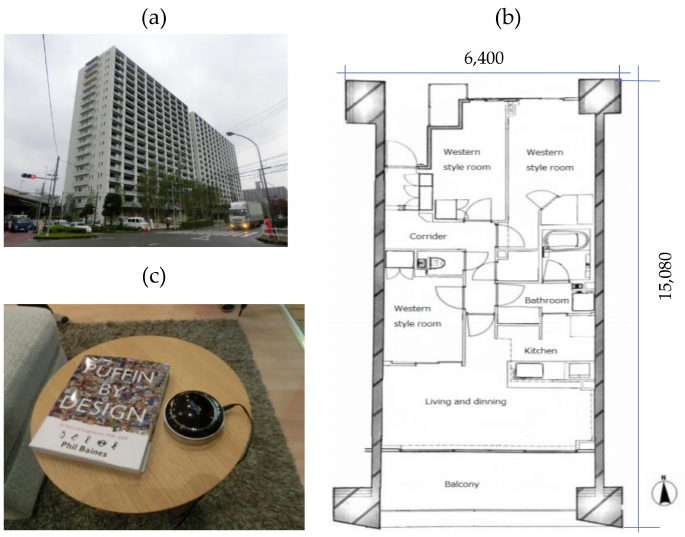
Figure 1. Studied condominium with the measuring device: ( a ) Studied building, ( b ) Floor plan of one of the selected flats, and ( c ) Measurement